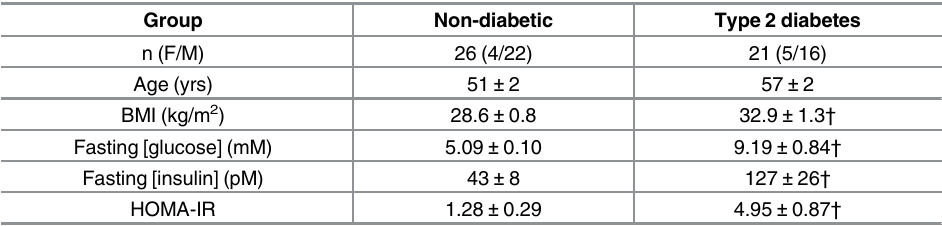
Table 1. Subject